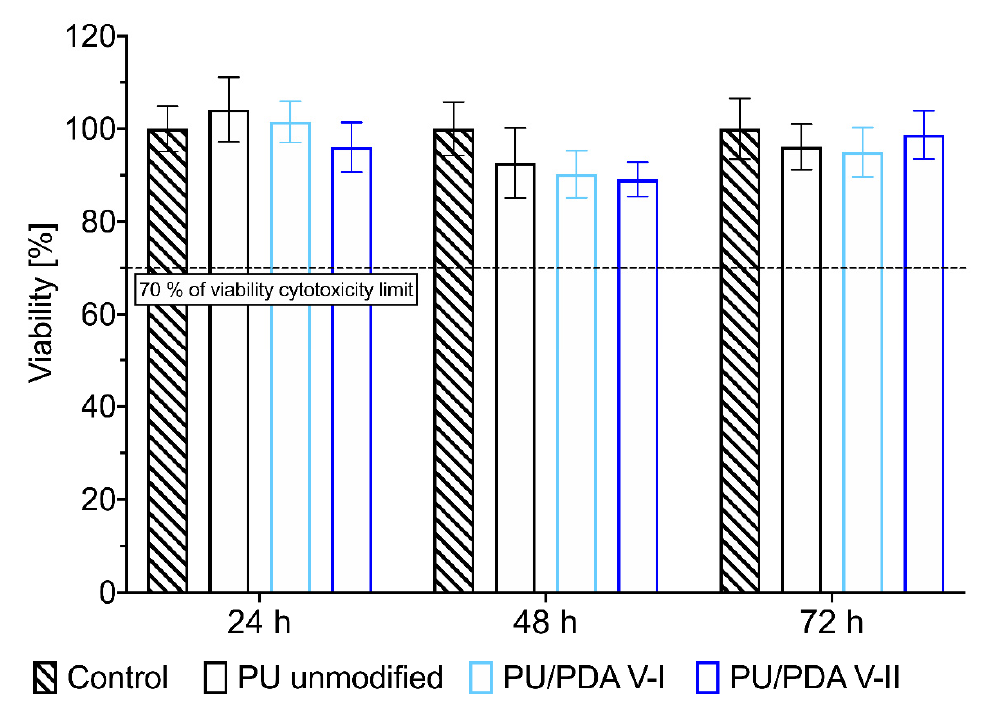
the modification, V-II, 0.5 h of modification).